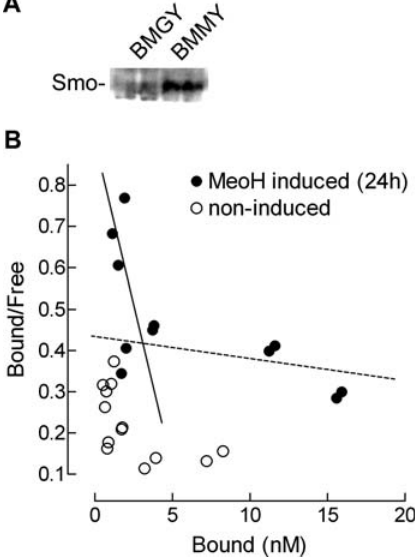
Figure 7. Scatchard Analysis of Vitamin D3 Using Smo-Expressing P. pastoris (A) 24 h methanol induction (buffered methanol-complex medium; BMMY) of Smo-transformed P. pastoris yielded successful Smo expression as shown by Western blot analysis with an antibody directed against Smo. (B) Scatchard analysis of heterologous competition with cyclopamine representing the binding of [3H]-D3 to Smo-expressing (solid circles, MeOH induced) and nonexpressing (open circles, noninduced) yeast strains. The solid line indicates the induced high-affinity binding, whereas the dotted line indicates nonspecific low-affinity binding. Scatchard analysis and fitting was performed as described earlier [53]. DOI: